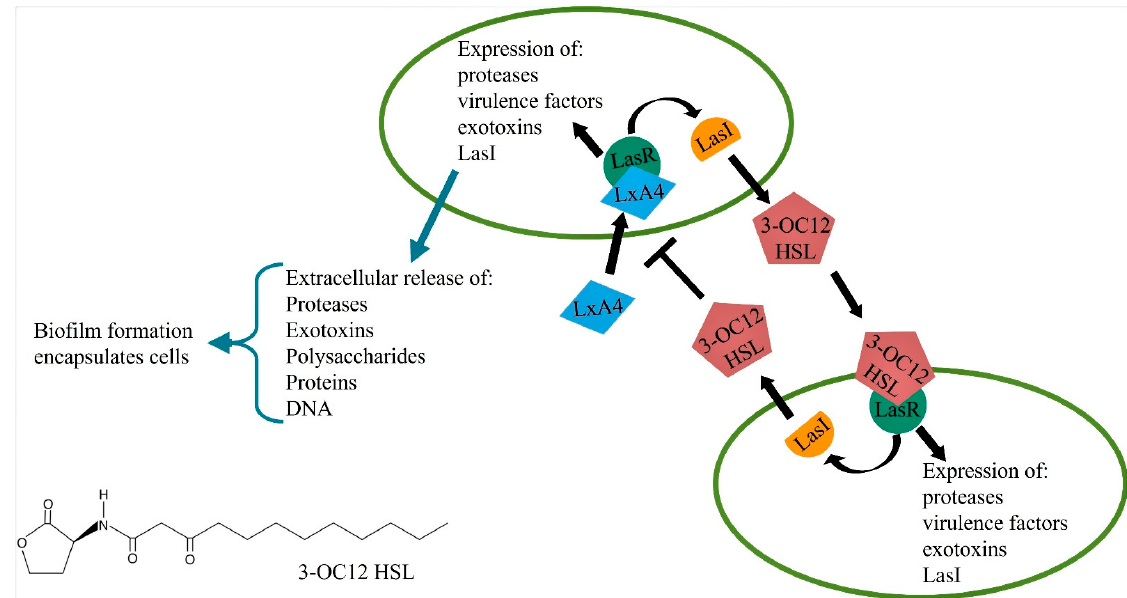
Figure 2. Bacteria such as Pseudomonas aeruginosa activate a quorum sensing signaling pathway when their population density reaches a particular threshold. In LasI/LasR pathway, LasI signaling increases production of quorum sensing inducer, N-3-oxododecanoyl-homoserine lactone (3—OC12-HSL). 3—OC12-HSL binds to its cognate receptor LasR, and then increases expression of virulence genes. This promotes release of exotoxins and proteases, and increases antibiotic resistance as well as biofilm formation, all of which augments virulence. LxA4 binds to and inhibits LasR receptor, which reduces Pseudomonas aeruginosa virulence.